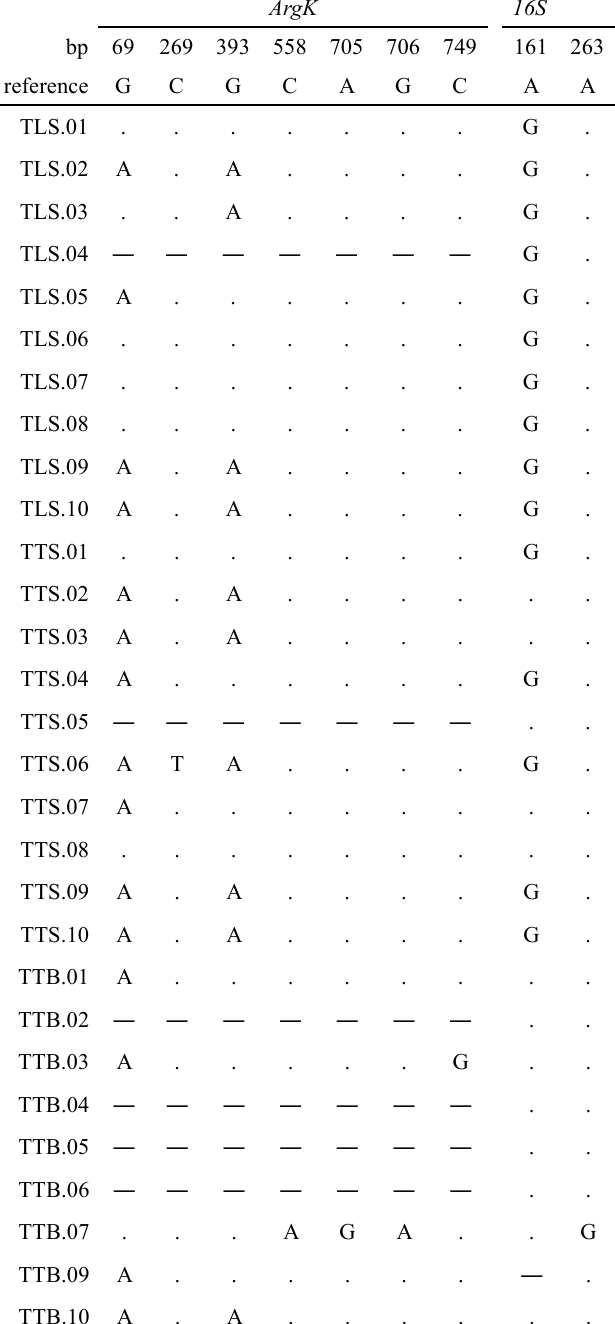
Table 2 . Point mutations found in the alignments of the two genes ( ArgK and 16S ). GenBank sequences from Bombus terrestris were concatenated and taken as reference ( ArgK : AF492888.1, 16S : AY737386.1) (bp = position of the mutation in base pairs; . = same nucleotide as in the reference sequence; ― = missing data). ArgK 16S